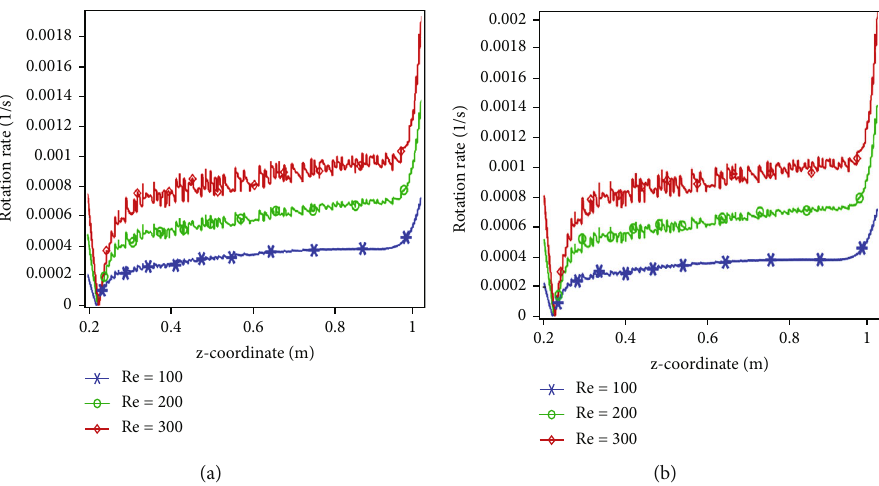
Figure 20: Measurement of rotation rate through the center middle of the downstream of backward step channel at with a = 0 : 5 : (a) I : C = 1 % and (b) I : C = 3 % .